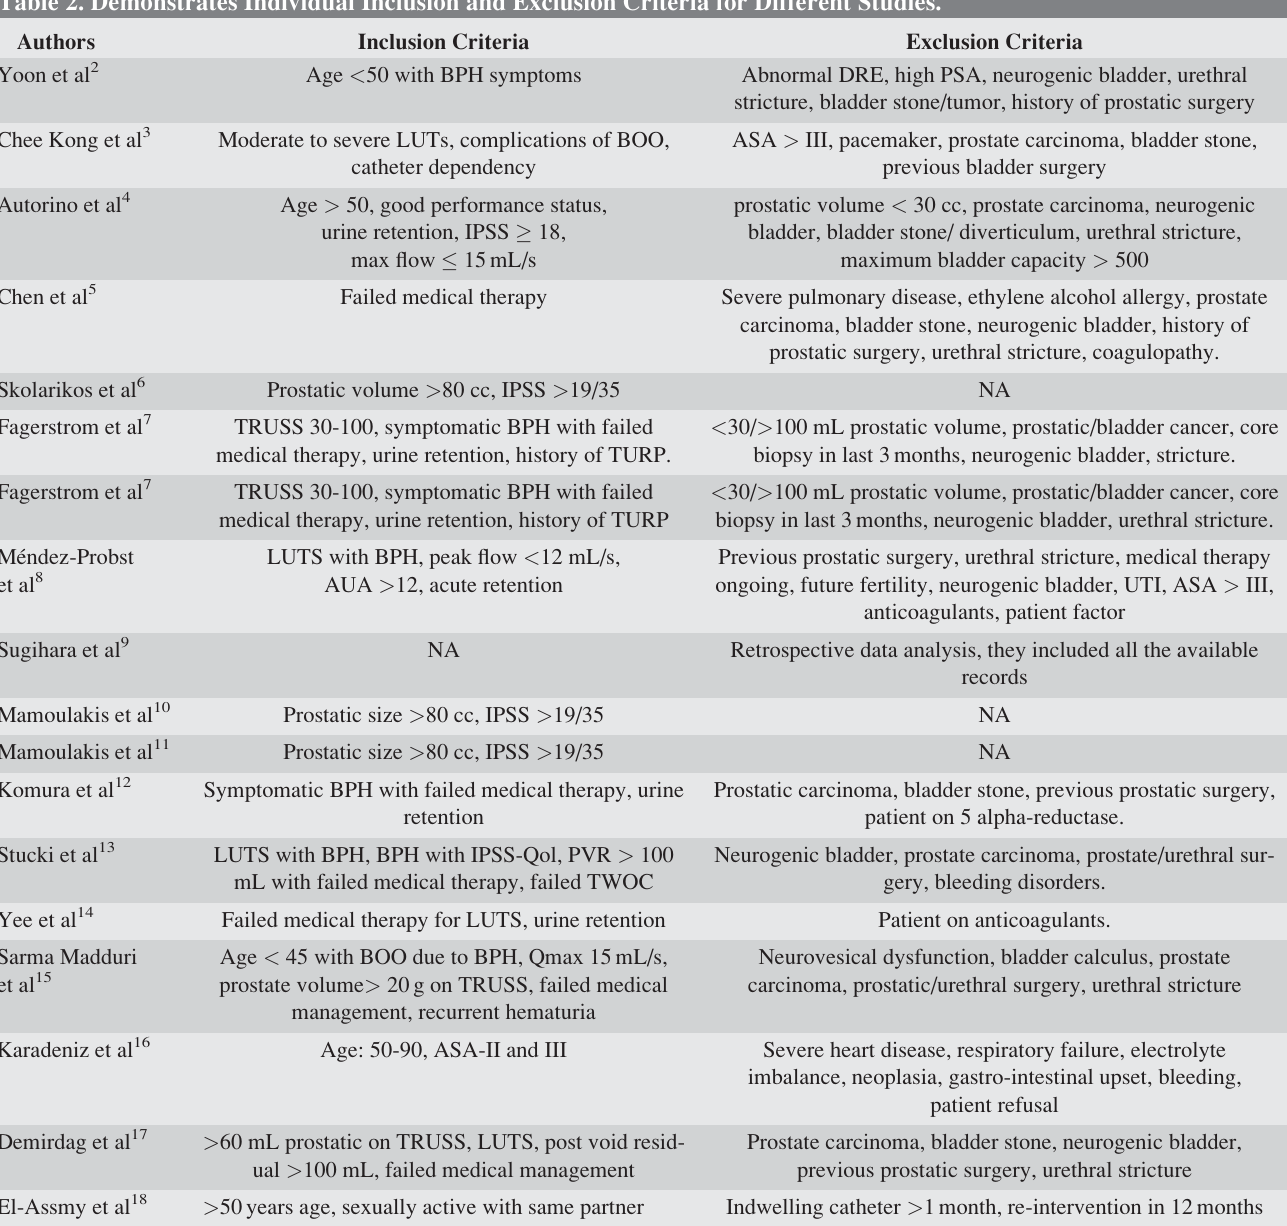
Table 2. Demonstrates Individual Inclusion and Exclusion Criteria for Different